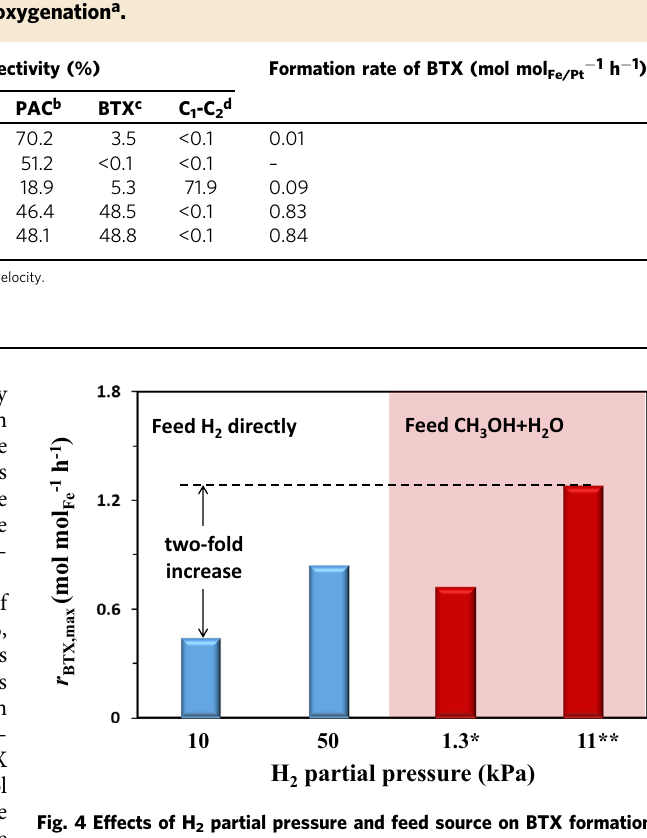
Table 1 Catalytic performance of gas-phase guaiacol hydrodeoxygenation a .